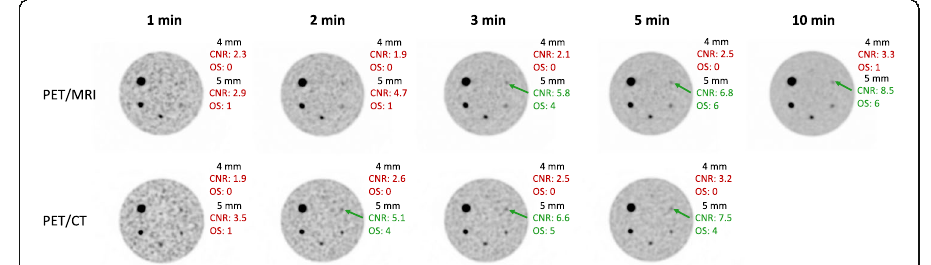
Fig. 6 PET images from the PET/MRI and PET/CT with 8:1 activity concentration for increasing acquisition times. Contrast-to-noise ratio (CNR) and observer scores (OS) for the hot spheres with a diameter of 4 mm and 5 mm are presented in red when the sphere was defined as non-detected and in green when the sphere was defined as detected. PET/MRI images are reconstructed with OSEM with PSF, while PET/CT images are reconstructed with OSEM with PSF and TOF, all with 3 iterations and 2 mm voxel size